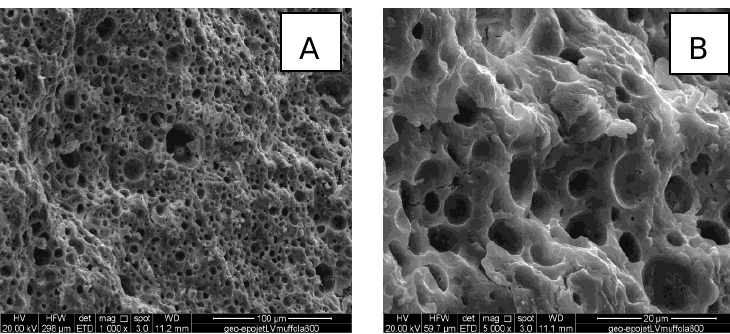
1 × 10 3 ( A ) and 5 × 10 3 ( B ) amplifications.